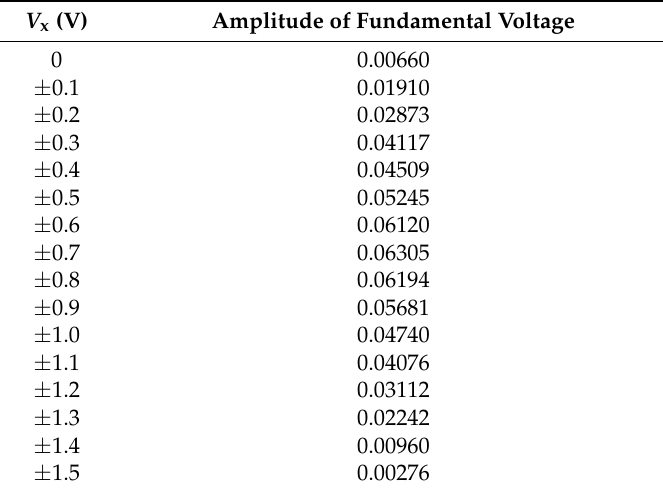
Table 1. Experimental